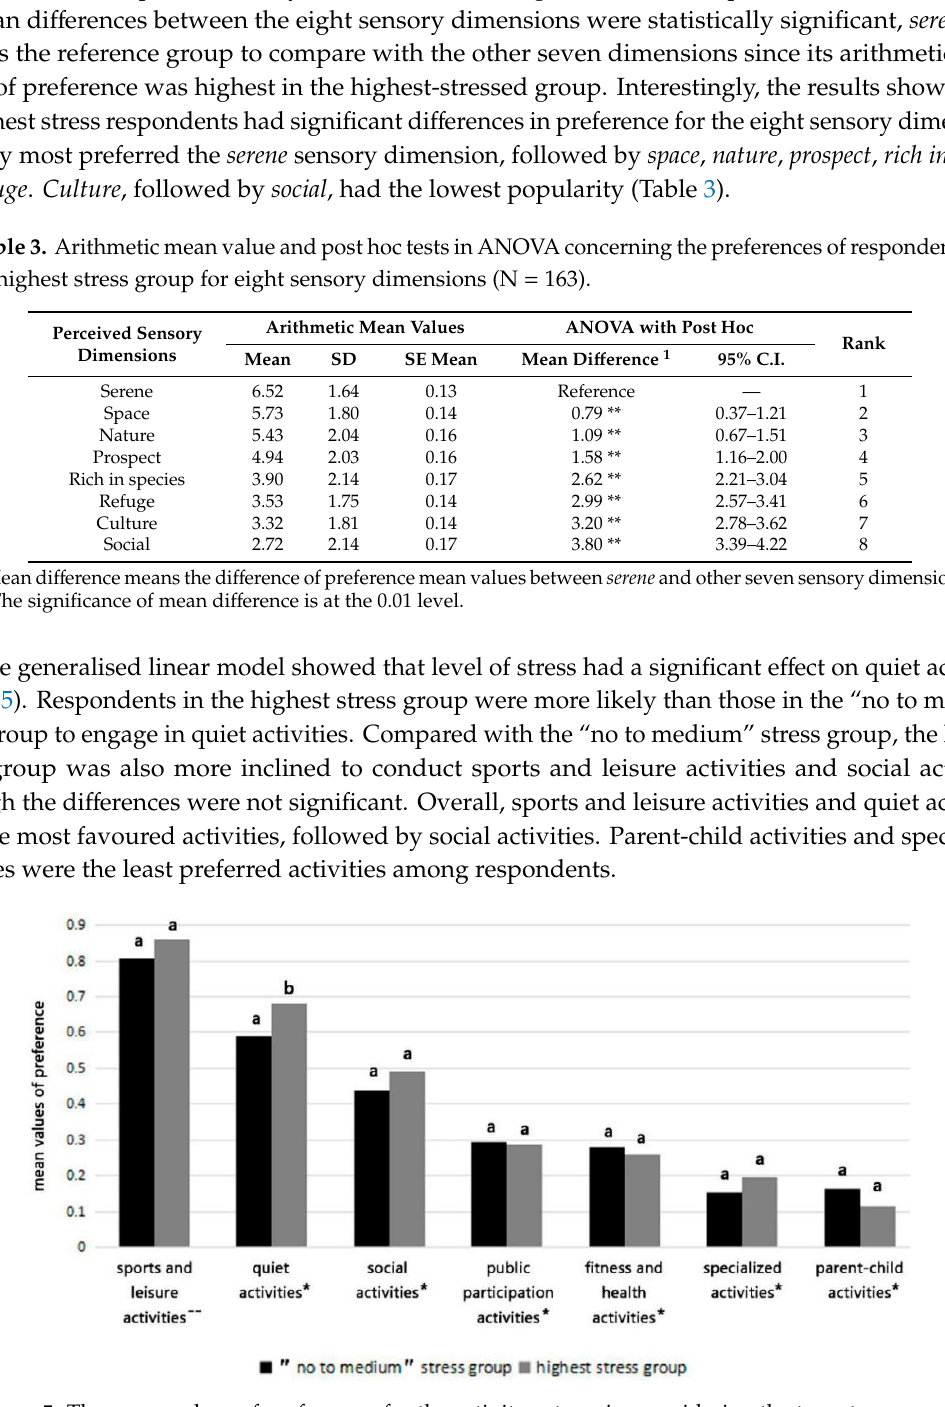
Figure 5. The mean values of preferences for the activity categories considering the two stress groups (no to medium stress group and highest stress group). Note I. The same letter within one activity category indicates that there is no significant difference in preference degrees for specific activity category between two stress groups, while the different letters within one activity category indicate that there is a significant difference. Note II. -- represents the reference activity category with the highest mean values of preference compared with the other six activity categories. * represents that there are significant differences of the mean values of preferences for specific activity categories compared with the reference activity category.